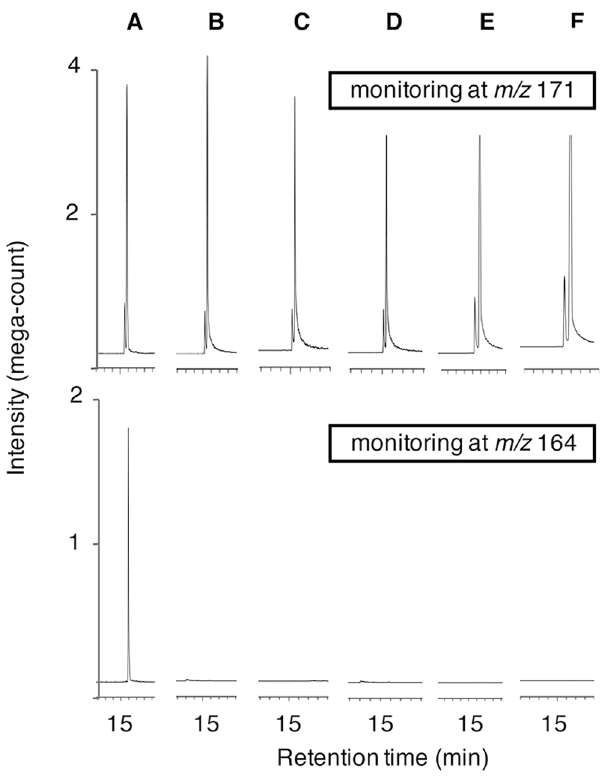
Figure 2. Representative GC MS chromatograms analyzing fungal derived cis -jasmone. ( A , B , C , D , E and F ) measuring fungal derived cis -jasmone using selected ion monitoring at m / z 164 (lower) and 171 (upper, internal standard) for L . theobromae , B . cinerea , V . longisporum , F . oxysporum , G . fujikuroi , and C . heterostrophus ,